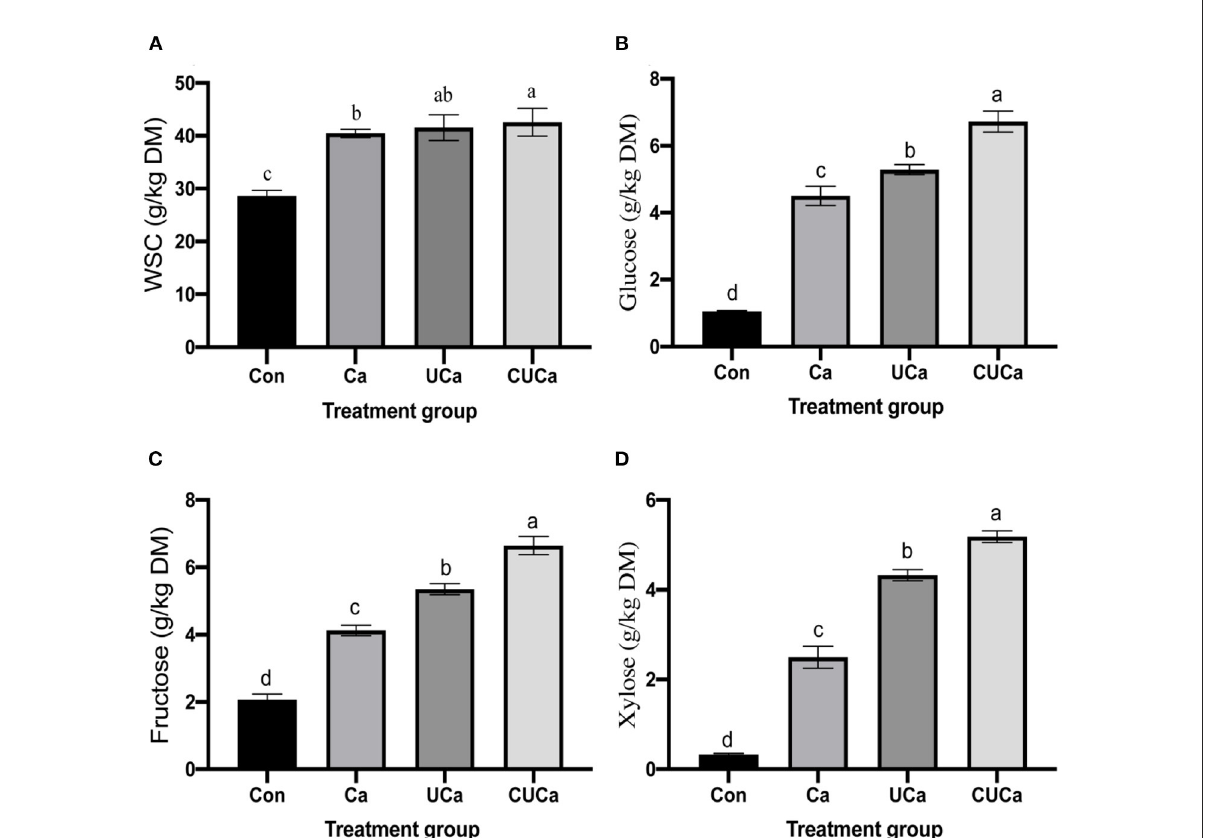
FIGURE5 Effect of CSL plus urea-alkali pretreatment on (A) water soluble carbohydrates (WSC) yield, (B) glucose, (C) fructose, and (D) xylose of rice straw. Con: no pretreatment for control group, Ca: 4% CaO, UCa: 2.5% urea + 4% CaO, CUCa: 9% CSL + 2.5% urea + 4% CaO. Different superscript letters a, b, c, and d indicates significantly different values ( P < 0.05) in different groups, and the same or no letters indicate insignificant differences ( P > 0.05).